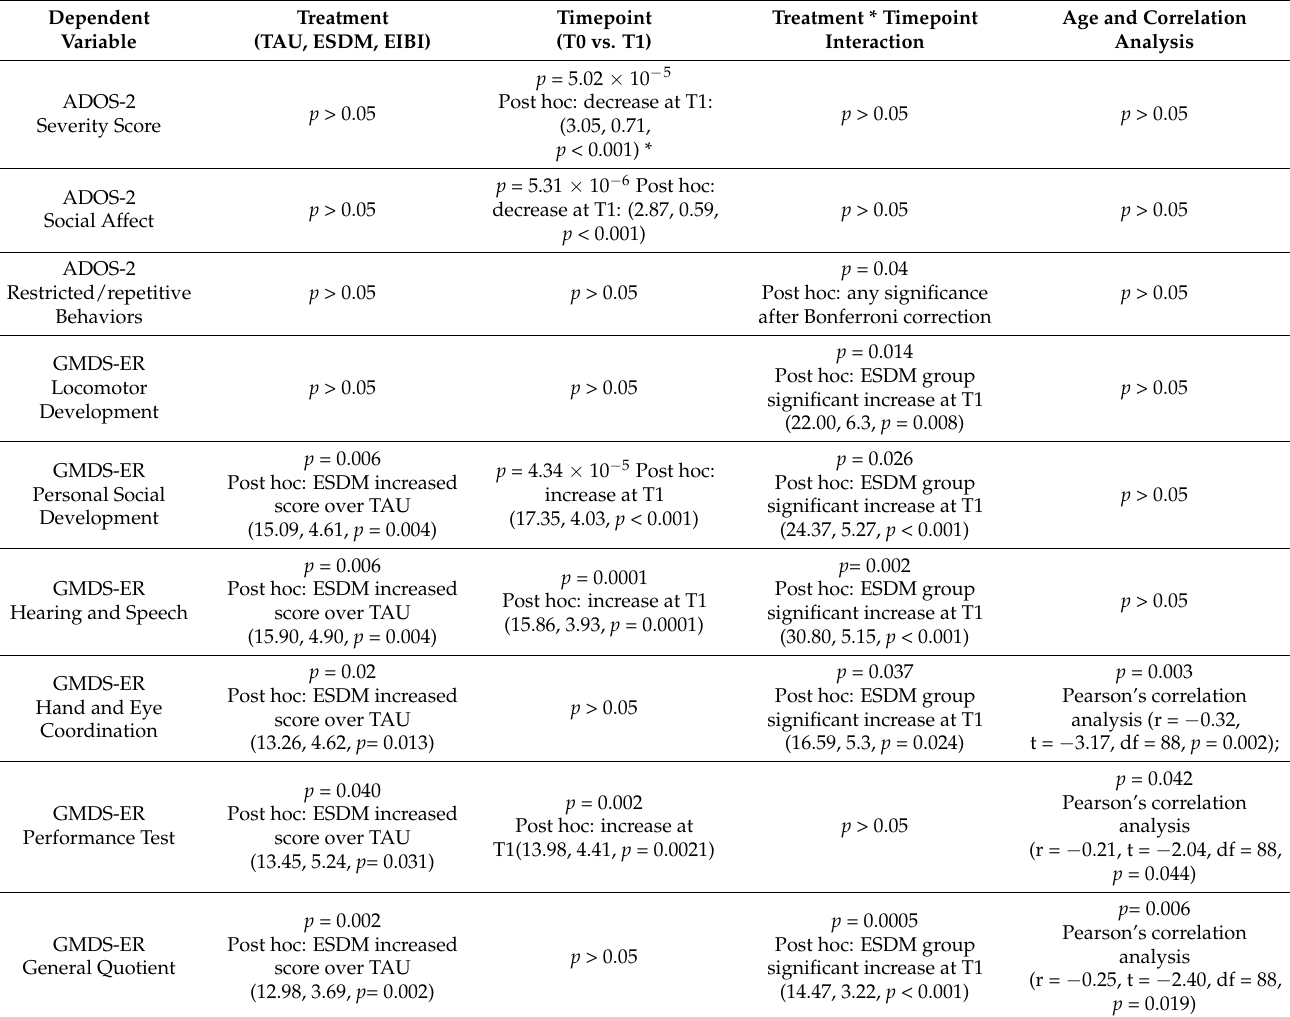
Table 3. Statistical results of retrospective analyses of ADOS and Griffiths scores and